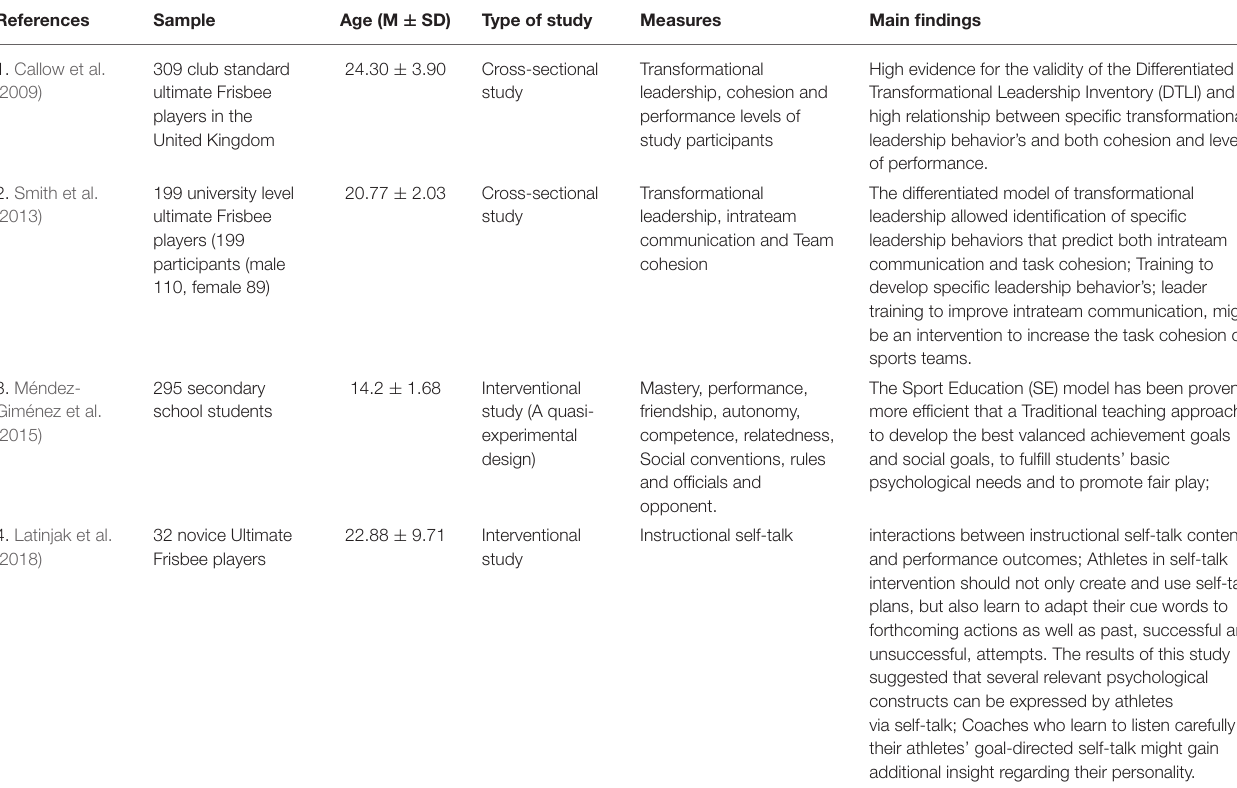
TABLE 4 | Summary of reviewed